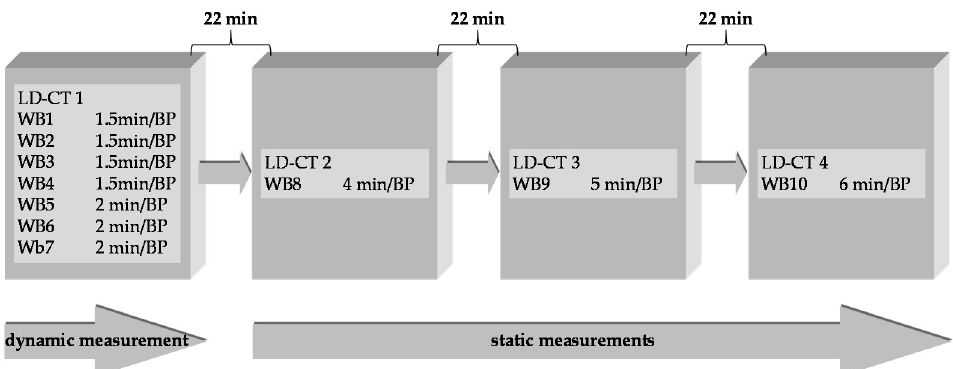
Figure 6. PET/CT imaging protocol comprising a dynamic and static part with increasing duration per bed position (BP) to compensate for decay and, thus, decreasing count statistics, preceded by a low-dose CT (LD-CT) for attenuation correction and anatomical orientation, respectively. Positioning of the animal in the PET field of view.